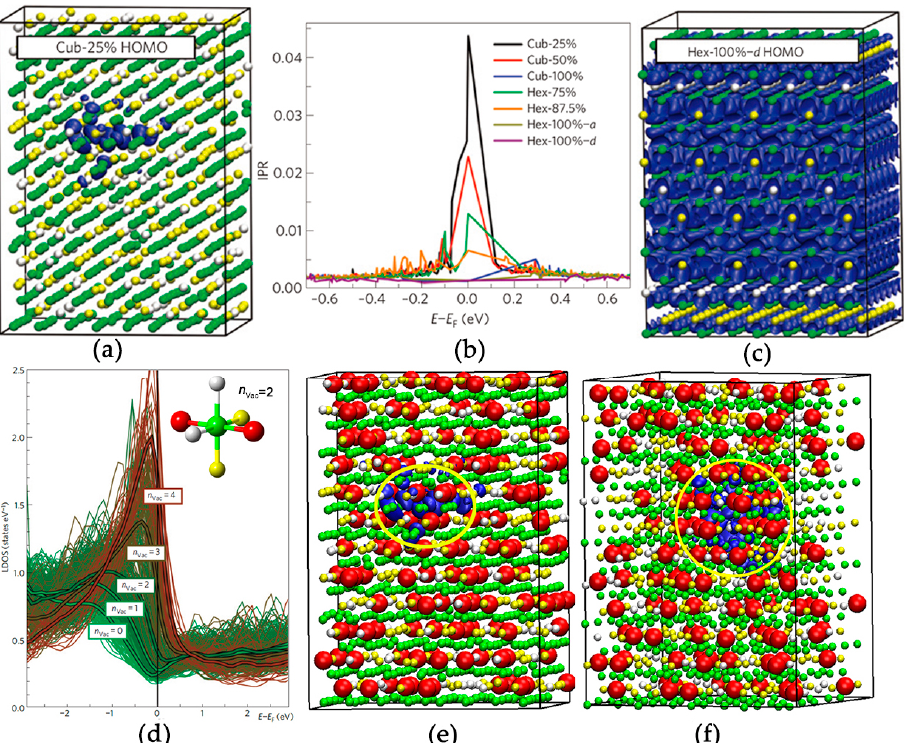
Figure 5. ( a , c ) Are the charge density distributions of the electron wave functions (blue spheres) of the disordered rocksalt Ge 1 Sb 2 Te 4 (Cub-25%) and the perfect hexagonal Ge 1 Sb 2 Te 4 (Hex-100%- d ) at the Fermi level, i.e., the highest occupied molecular orbital (HOMO) states. Ge, Sb and Te atoms are rendered with grey, yellow and green spheres, respectively; ( b ) Inverse participation ratio (IPR) curves for several rocksalt and hexagonal Ge 1 Sb 2 Te 4 models with different degree of disorder; ( d ) The local density of p states (LDOS) of the Te atoms, which are categorized according to the number of the nearest-neighbor vacant sites n Vac (inset) with different colors. The average LDOS of each n Vac group is shown as a thick line in the corresponding color. The atomic vacancies in (a) are highlighted with big red balls and are shown in ( e ). The yellow circle marks a vacancy cluster. ( f ) The highest occupied molecular orbital (HOMO) state of a rocksalt Ge 1 Sb 2 Te 4 model with a manually created vacancy cluster, which clearly localizes the electron wave functions. Adapted with permission from Reference [15] © 2012 Nature Publishing